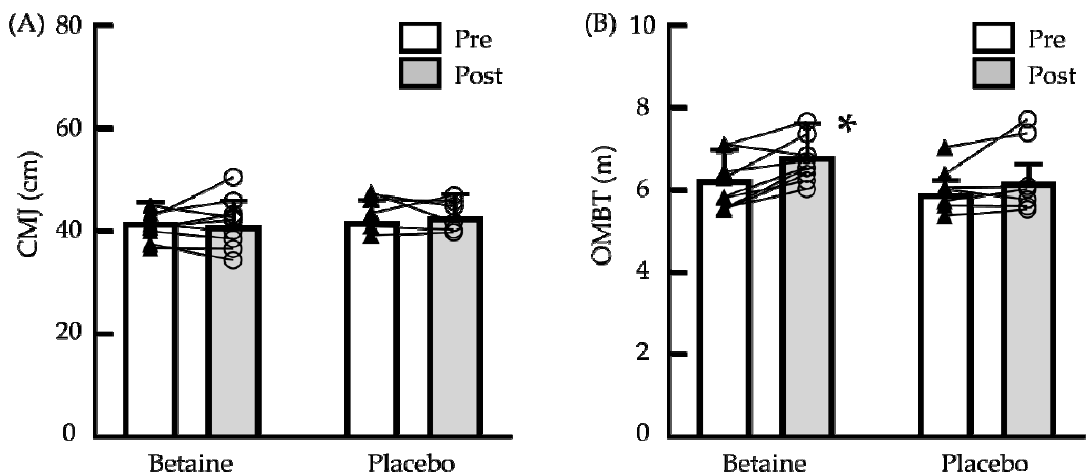
Figure 1. Changes in the muscle power of the upper and lower body before and after 6 weeks of betaine supplementation. ( A ) Overhead medicine ball throw (OMBT); ( B ) countermovement jump (CMJ). Pre: before supplementation; Post: after supplementation. The bars indicate means ± standard deviation. ▲ : Individual presupplementation values; ○ : Individual postsupplementation values; *: Significant difference from Pre ( p < 0.05).